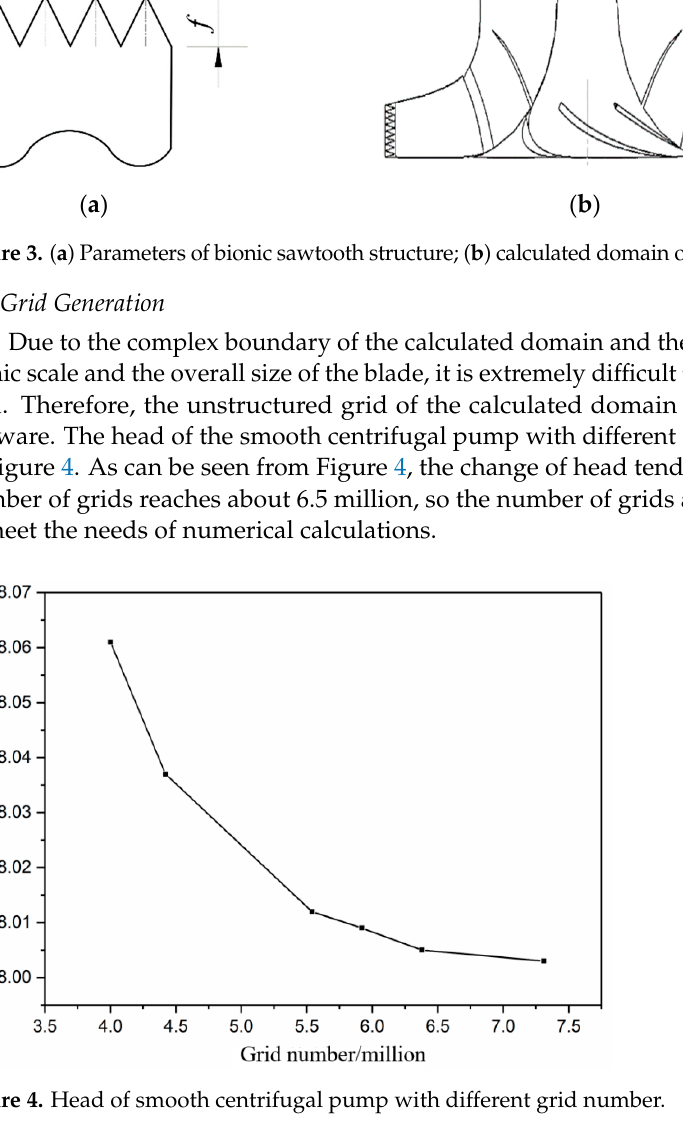
Figure 2. Rectangular arrangement of pit structure.